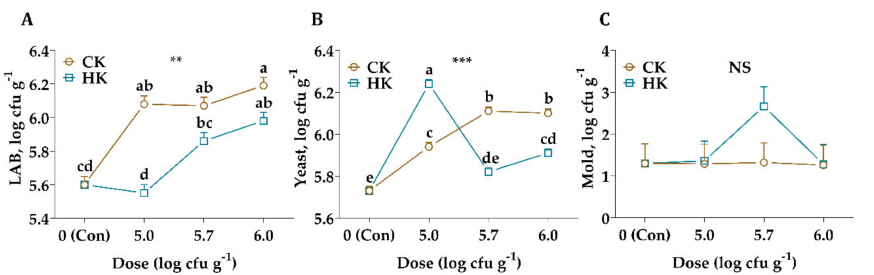
Figure 1. Changes in lactic acid bacteria (LAB, ( A )), yeast ( B ), and mold ( C ) count of alfalfa silage after 45 d of ensiling. CK: commercial kefir, HK, homemade kefir, cfu: colony-forming units. The values with different letters (a, b, c, d) in each graph are statistically different ( p < 0.05), NS: not significant, ** : p < 0.01, *** : p < 0.001.